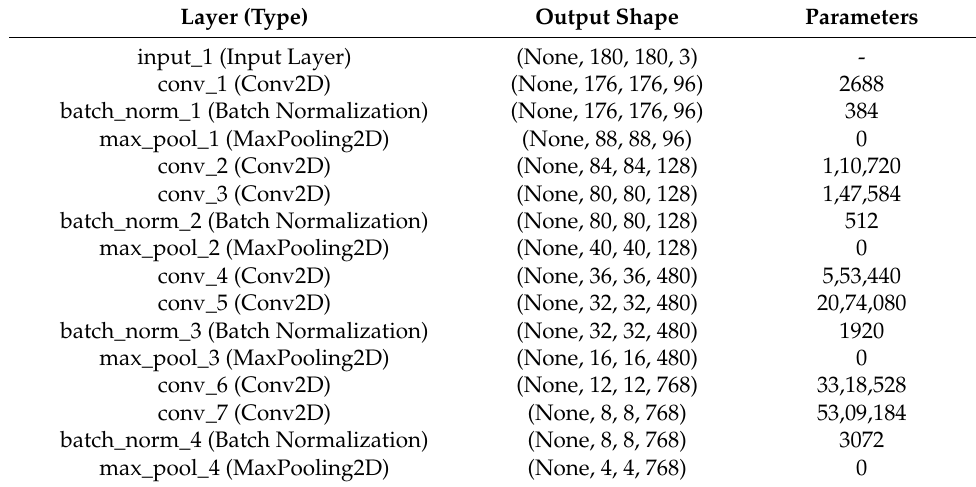
Table 3. Dilated CNN (DCNN) model architecture.